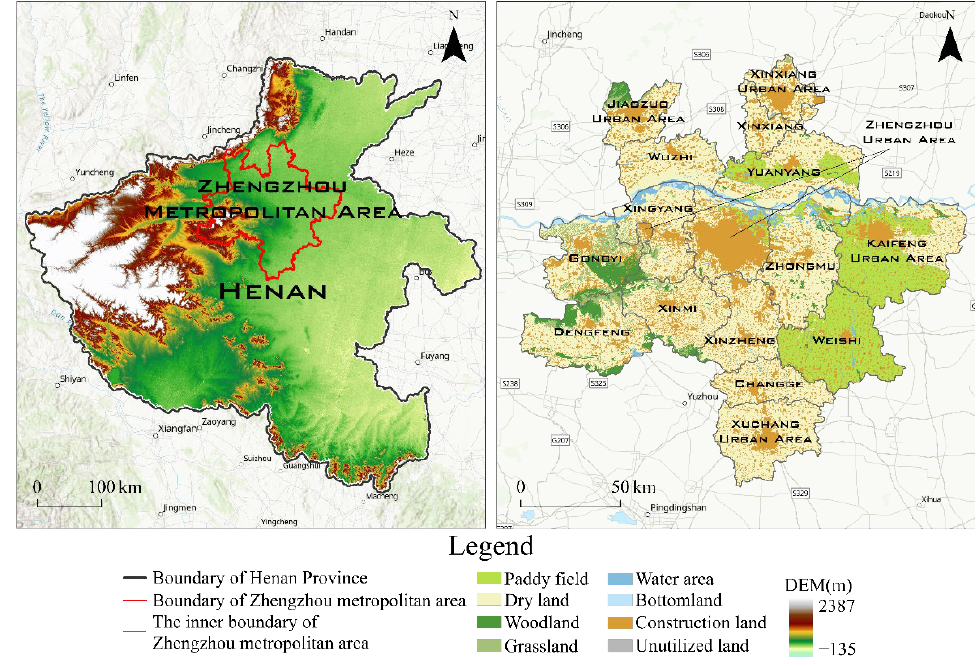
Figure 1. Geographical location of Zhengzhou Metropolitan Area.